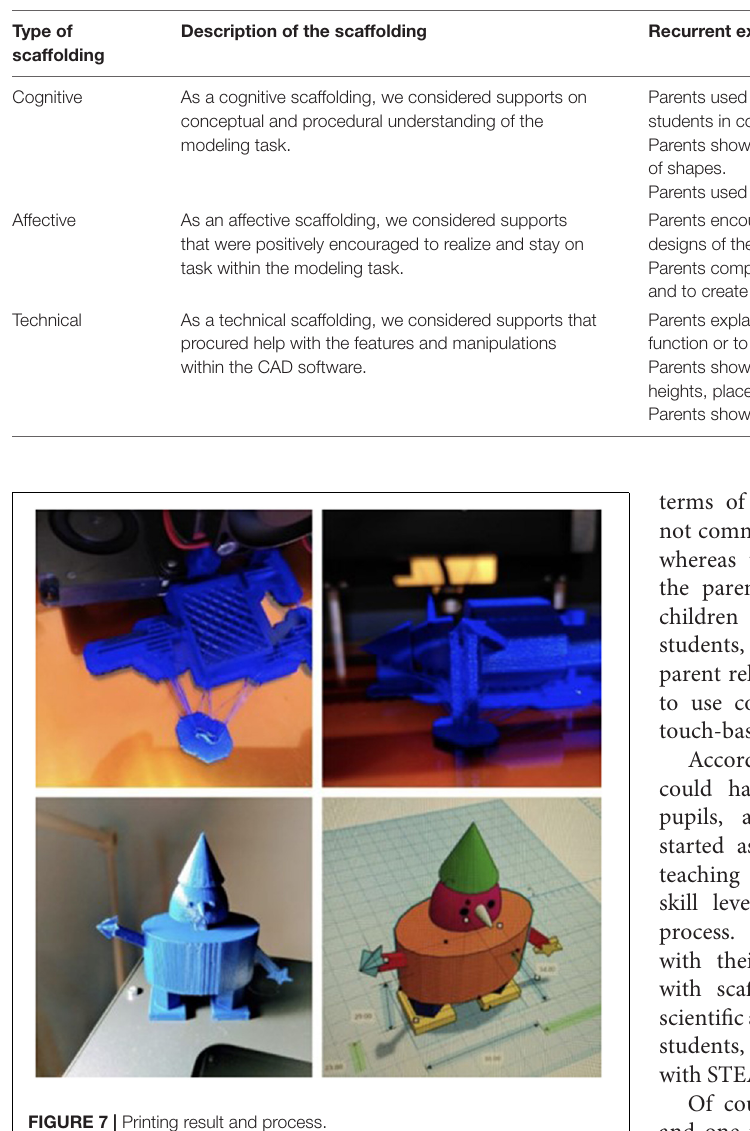
TABLE 3 | Observed scaffoldings done by parents.